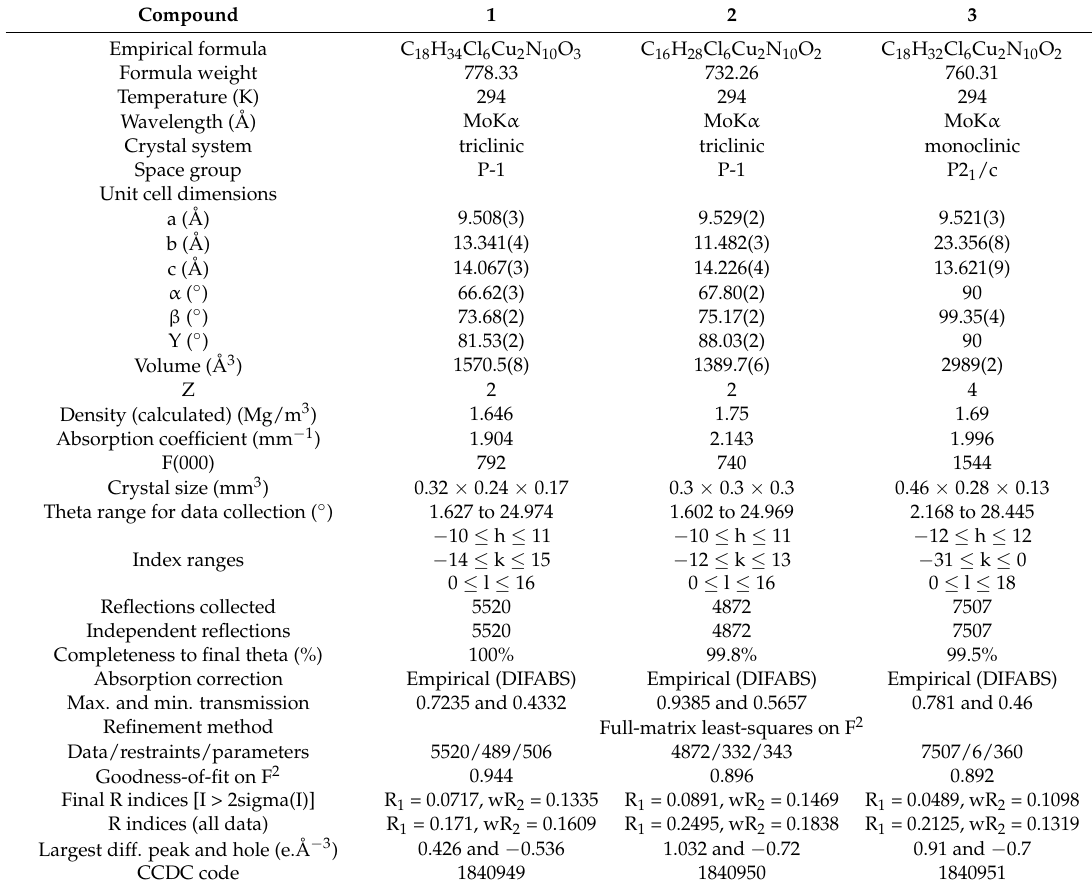
Table 3. Selected crystallographic data for compounds 1 – 3 .